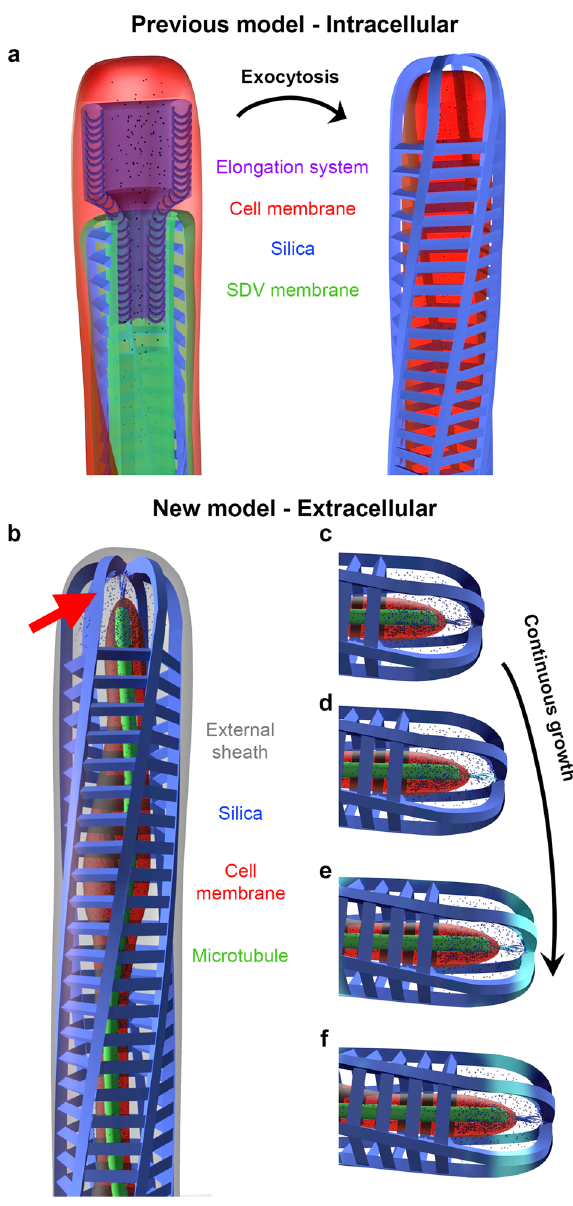
Fig. 6 Schematic representations of SDV-mediated and non SDV- mediated models for seta formation. a An SDV-mediated process that includes an SDV membrane surrounding the forming silica, and a dedicated cellular complex that is responsible for elongation of the seta (based on the works of J. Pickett-Heaps). Only after maturation the silica is exocytosed and become exterior to the cell membrane. b The new model based on the components identi fi ed by cryoET, with the addition of Si building blocks as small spheres, and the putative organic scaffolds that emanate from the far end of the cell cytoplasm, indicated with a red arrow. c – f Steps in the seta elongation process. A newly formed section of the organic scaffold (cyan in d – f ) silici fi es upon radial expansion, and then is pushed down along the seta. The organic cover was removed for